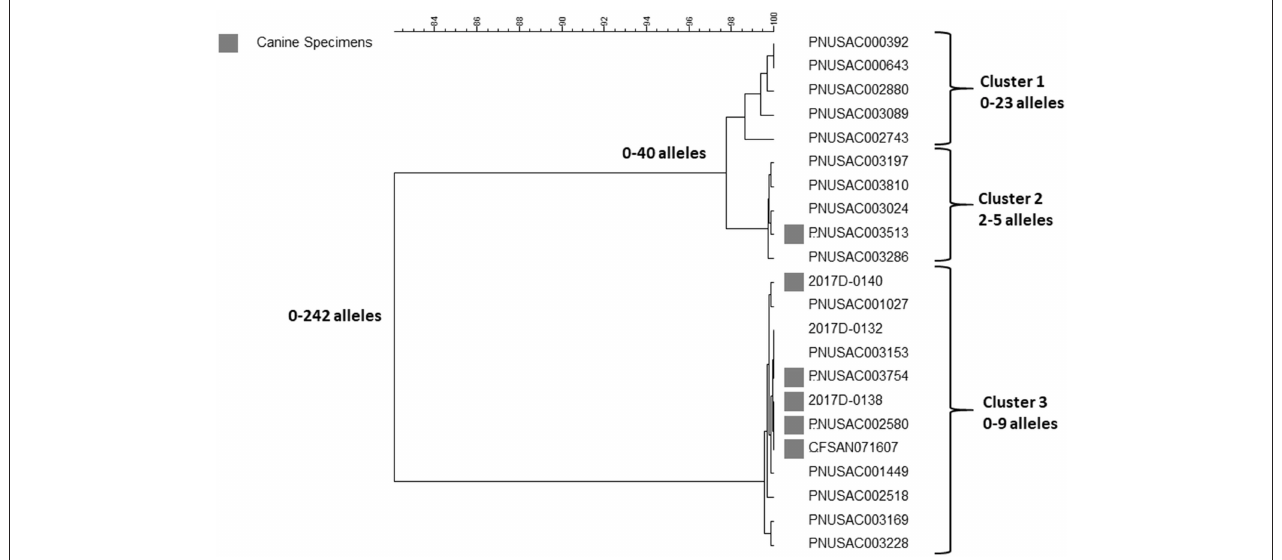
FIGURE 4 | cgMLST UPGMA tree of a representative sample of sequences of clinical and animal isolates of Campylobacter jejuni from an outbreak associated with contact to puppies sold in a specific pet store chain. Puppy isolates are marked with gray squares. The range of allele differences are indicated at the branches of the tree and clusters to the right of the